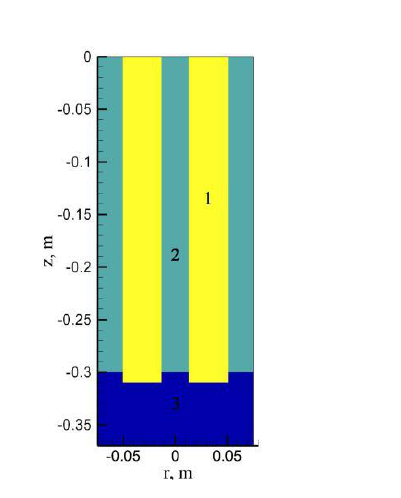
Figure 1. Calculation domains of electroslag remelting (ESR). (1) Electrode. (2) Air. (3) Slag pool.